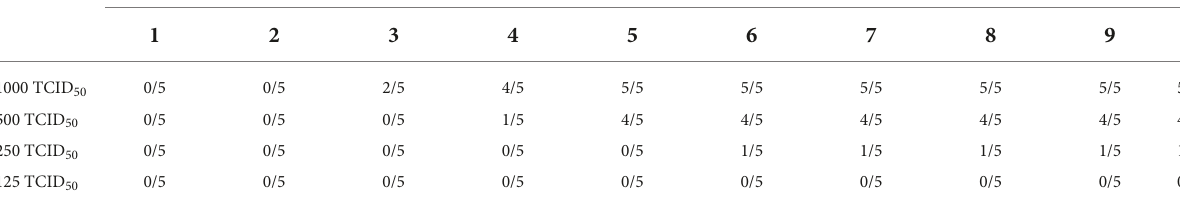
TABLE 2 Death of rabbits during the 10-day observation period.